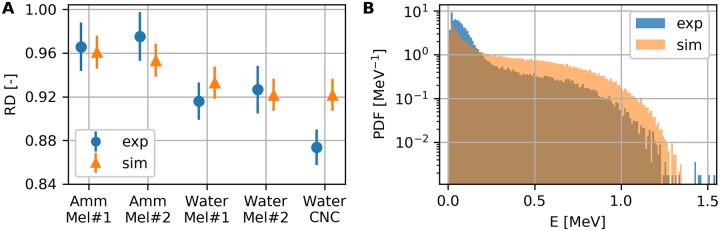
Shielding effectiveness of melanin mixtures.(A) Shielding effectiveness of melanin mixtures in ammonia (Amm) and water, for synthetic melanin (Mel#1) and melanin of S. officinalis (Mel#2). For comparison, slurry of cellulose nano-crystals (CNC) was also tested. Experimental measurements are shown in circles and numerical simulation results in squares. (B) Comparison between experiment and simulation of the estimated probability density function of the deposited energy spectrum. Results for the S. officinalis and water suspension.